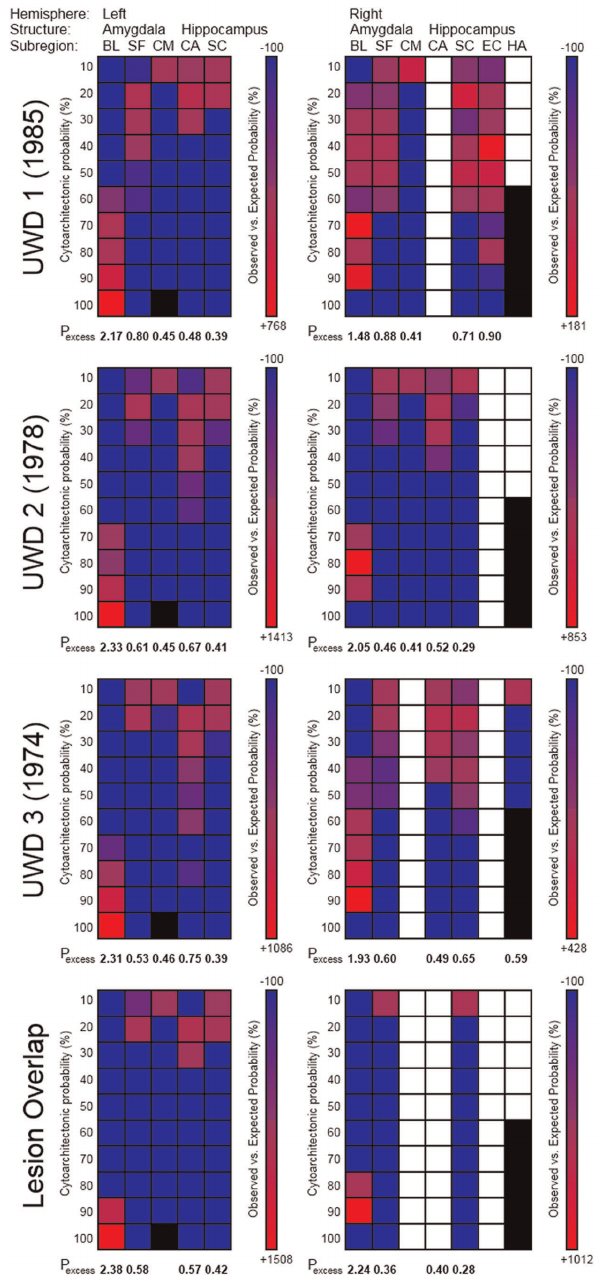
Figure 4. Observed versus expected probability matrices for the individual brain lesions and their overlap. Columns are the observed brain areas, and rows their cytoarchitectonic probability classes. Colors indicate the relative over- (red) or under- (blue) representation of a structure-class in the lesion volume. White indicates no overlap between lesion and structure probability map, and black indicates probability classes that are not represented in the cytoarch- itectonic map. P excess values indicate how much more likely a structure was observed in the lesion volume as could be expected from its own probability distribution, and thus reflect how central to the area the lesion volume is. BL=Basolateral, SF=Superficial, and CM=Central- Medial, which are all amygdala subregions, and CA=Cornu Ammonis, SC=Subicular Complex, EC=Entorhinal Cortex, and HA=Hippocampal- Amygdaloid Transition Area, which are all subregions of the hippo- campus.